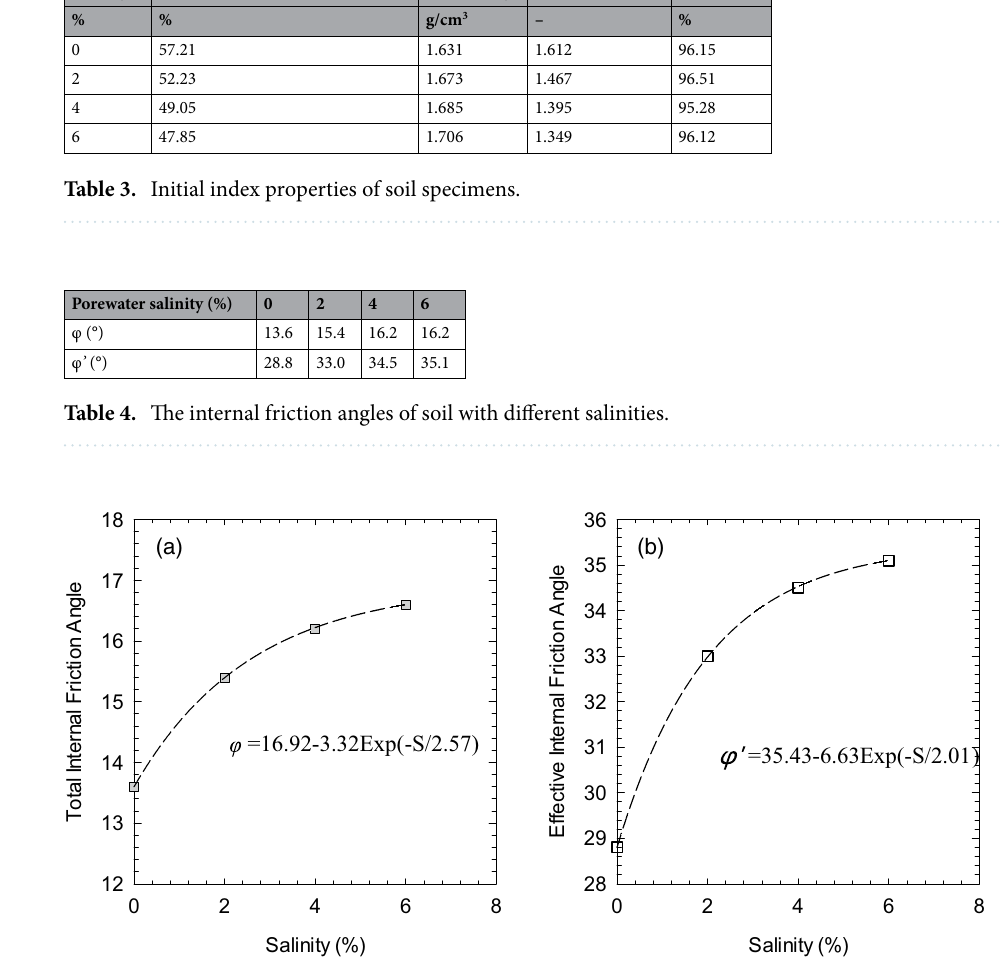
Figure 3. ( a ) Total internal friction angle and ( b ) Effective internal friction angle versus